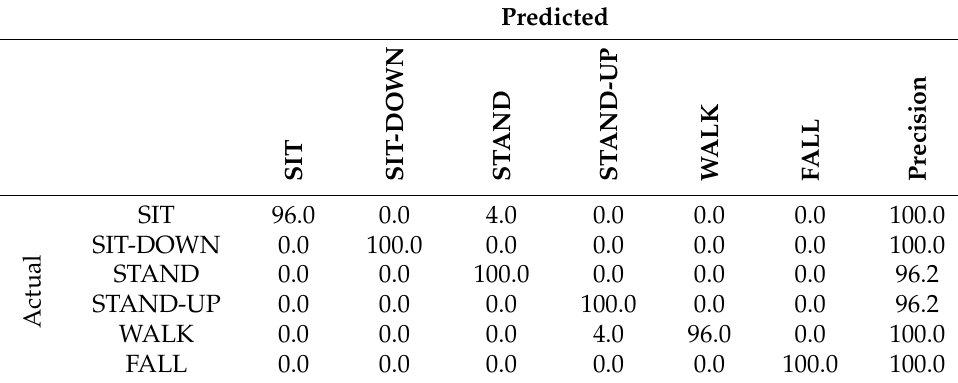
Table 6. Confusion matrix for scaled data for Experiment 2.